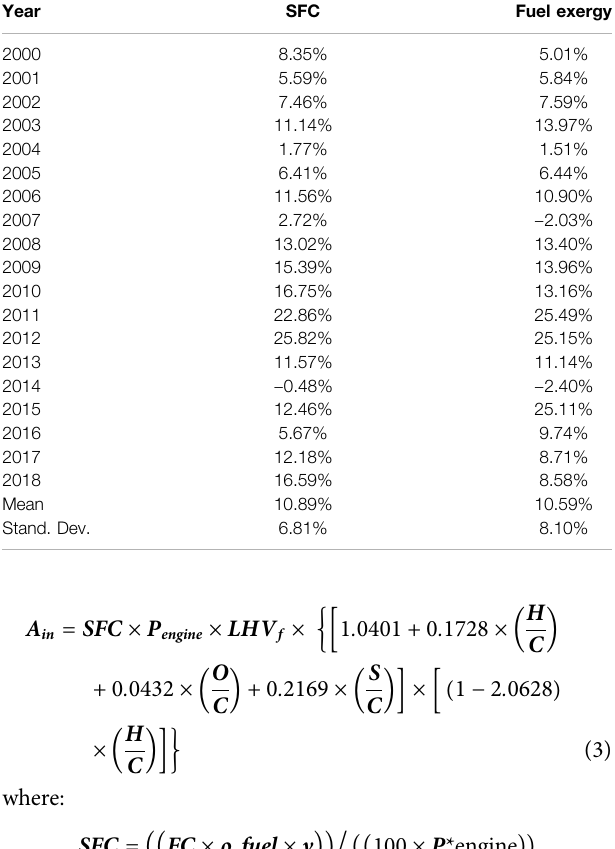
TABLE 2 | Percent error in exergy estimation between Eqs 1 , 3 , SFC and Fuel